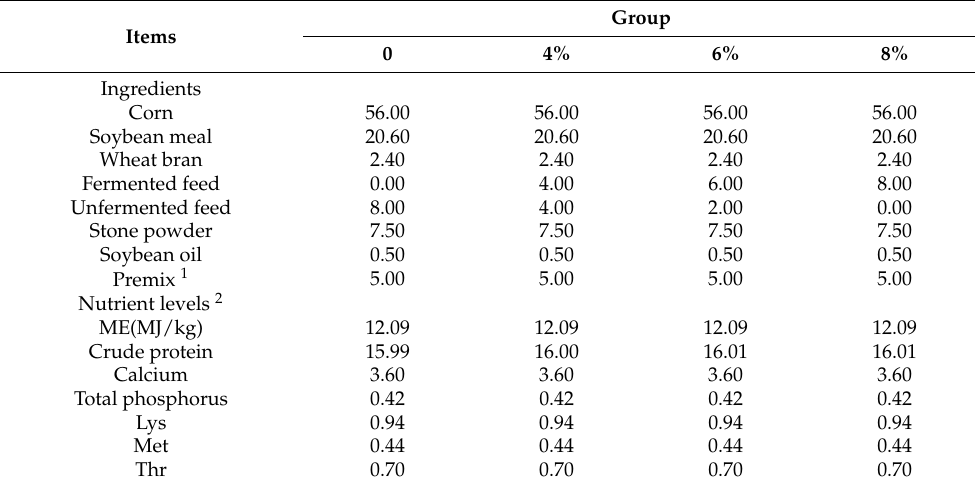
Table 1. Composition and nutrient levels of experimental diets (air-dry basis, %).